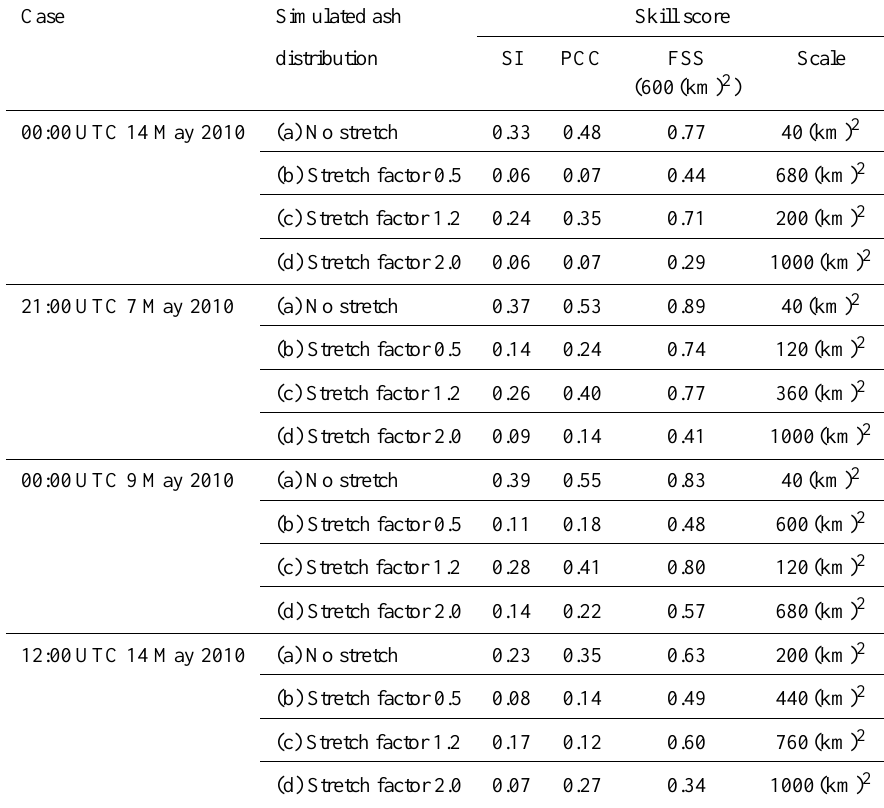
Table 1. The value of success index (SI), Pearson correlation coefficient (PCC), FSS for a neighbourhood of 600(km) 2 and the scale at which the FSS reaches a value of 0.5 for the scenarios presented in Figs. 4–7.